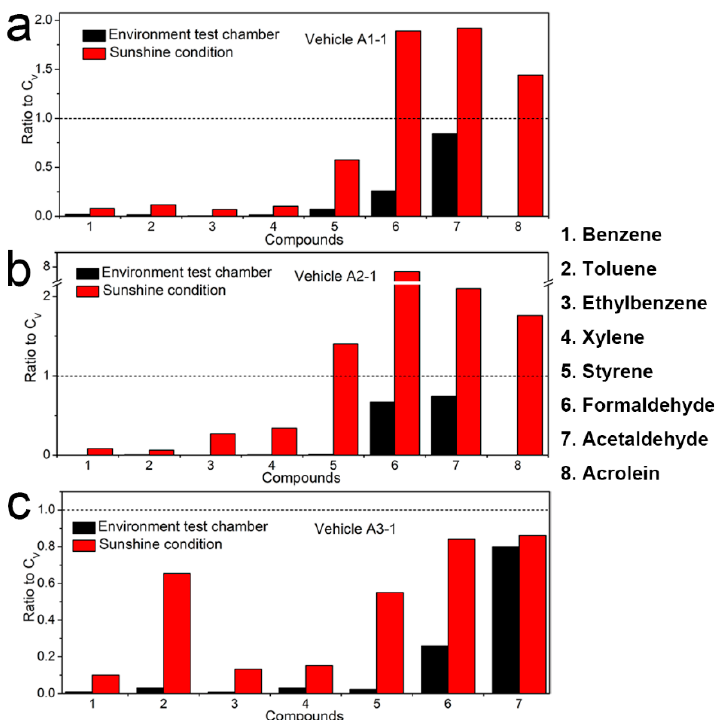
Figure 3. The ratios of concentrations of eight confirmed compounds measured inside ( a ) Vehicle A1-1, ( b ) Vehicle A2-1, ( c ) Vehicle A3-1 in the environment test chamber (C E ) with sunny outdoor conditions (C S ) to their corresponding limited values (C V ) of the national standard GB/T 27630, respectively. The black short dash corresponds to a value of 1.